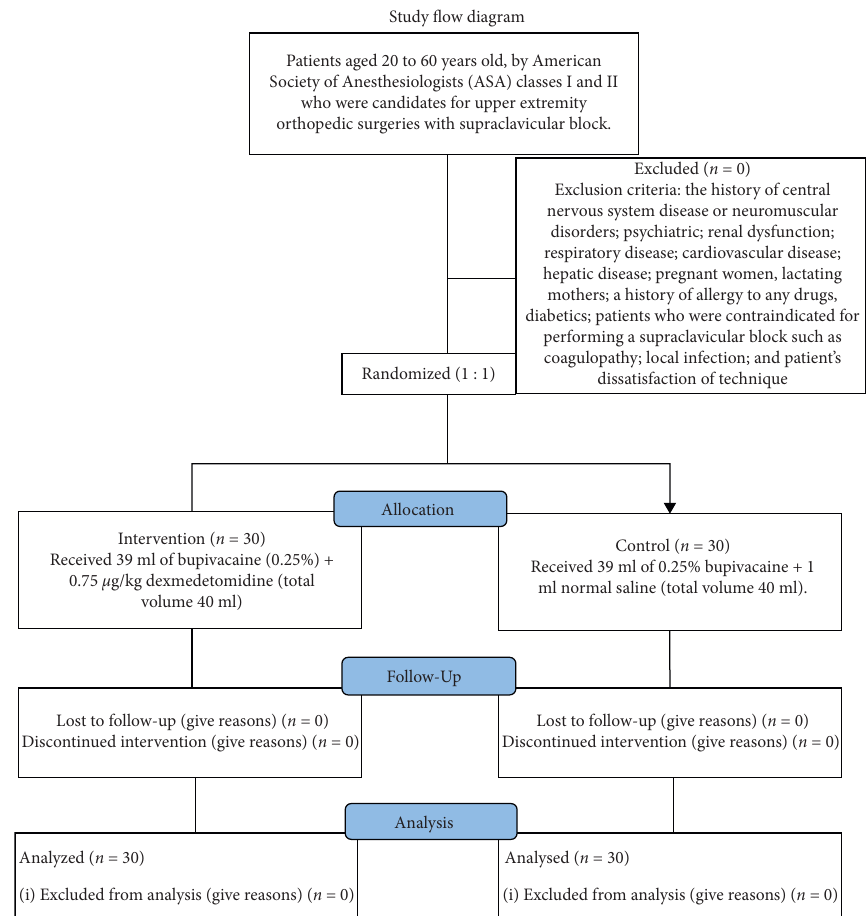
Figure 1: Study fow